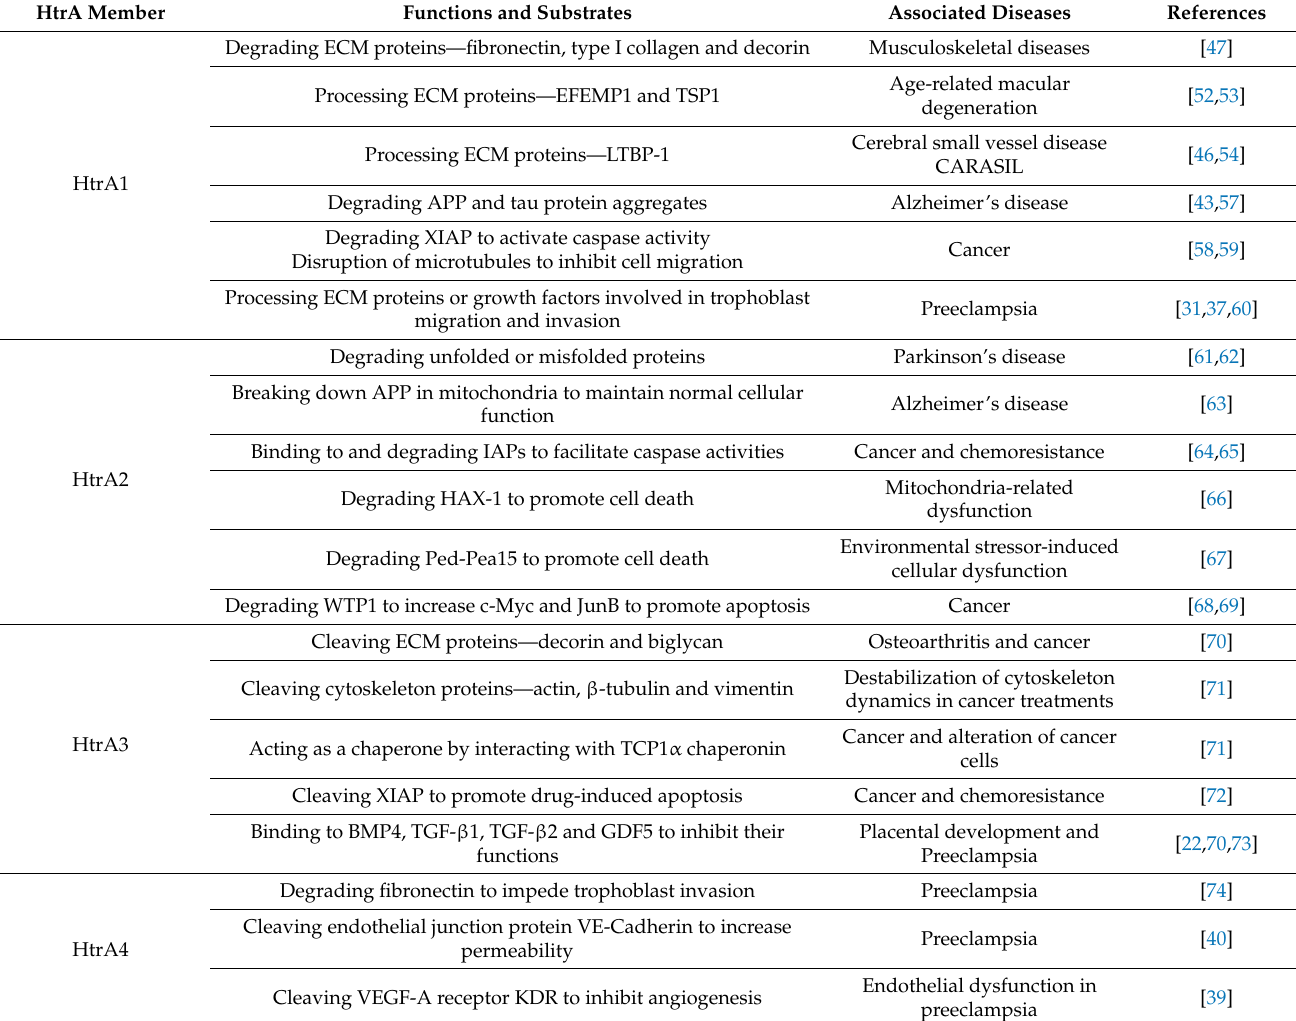
Table 3. Potential functions and substrates of human HtrAs in association with various diseases. HtrA Member Functions and Substrates Associated